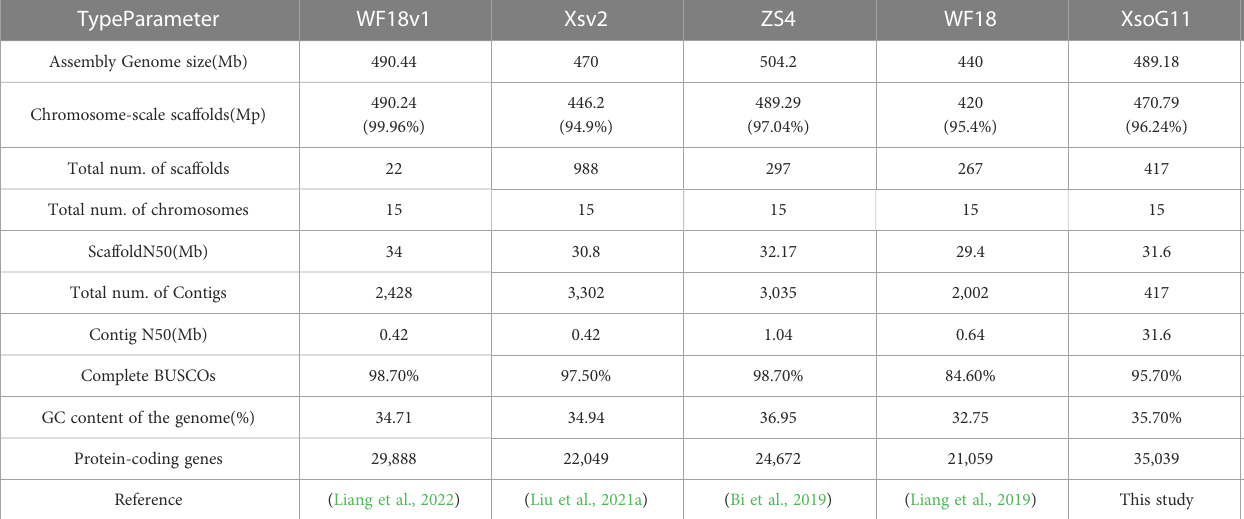
TABLE 2 Statistic of different yellowhorn genome